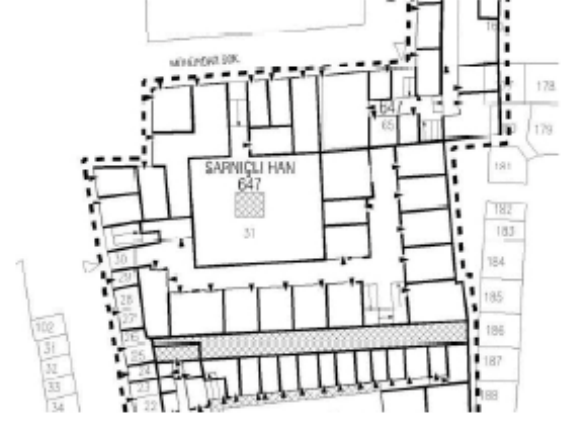
Figure 3. Brick masonry of the arches supporting